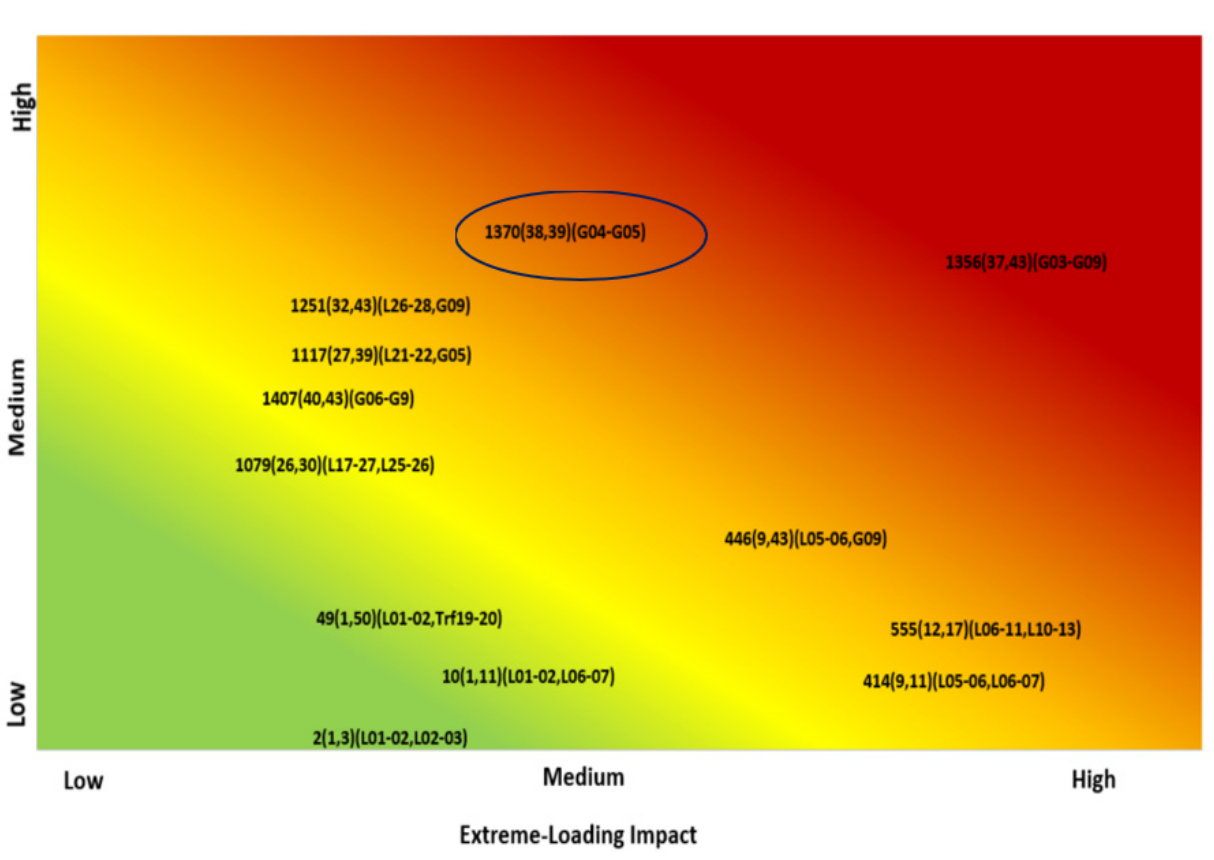
Figure 4. Risk-based extreme-loading contingency chart. For example, contingency number 1370 (indicated) in which the component number 38 (G-04) and component number 39 (G-05) are involved falls in the medium impact high probability (MIHP) region.